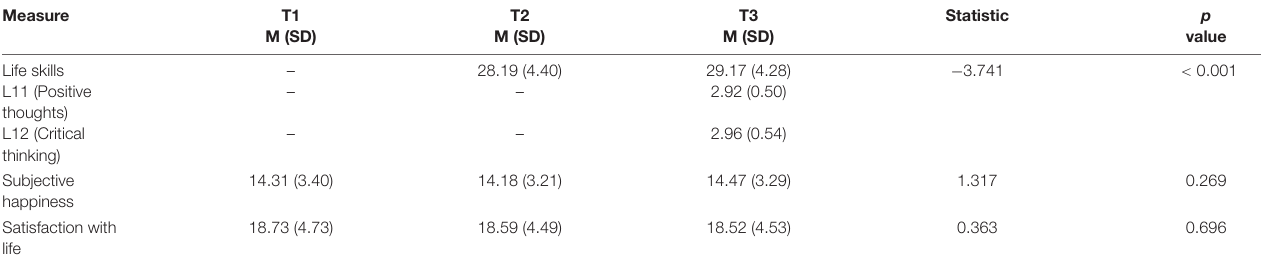
TABLE 1 | Scores on survey data assessed over the duration of the course. Measure